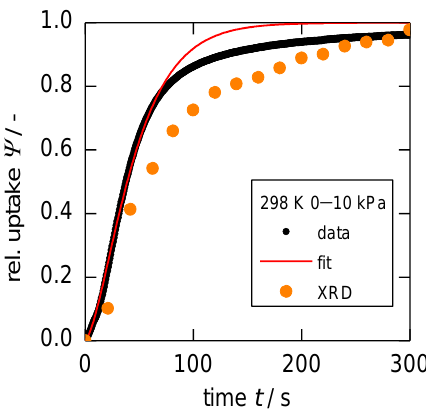
Figure 5. Gravimetric uptake of n -butane on 1 at 298 K after a pressure step 0 → 10 kPa, the fitted model presented in this work and the uptake as derived from PXRD data measured under the same conditions, representing the state of structural transition in dependence of time.